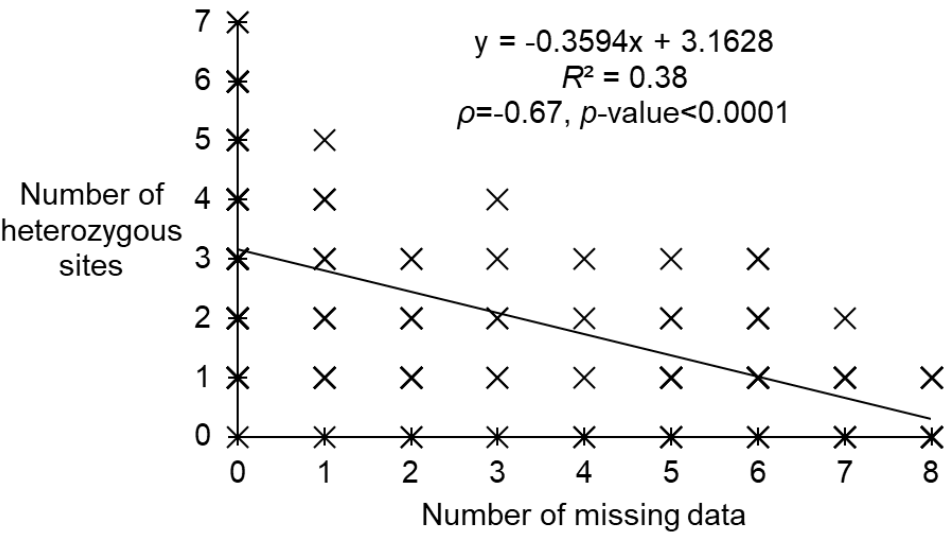
Figure 1: Correlation between the number of missing genotypes (blanks or not interpretable results) and the number of heterozygous sites in Trypanosoma lewisi isolates. Regression equation and determinant coefficient are presented for the sake of illustration. Spearman's rank correlation and one- sided test outputs are also